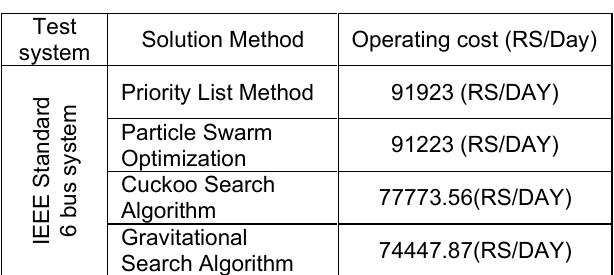
Table 6. Performance Comparison with